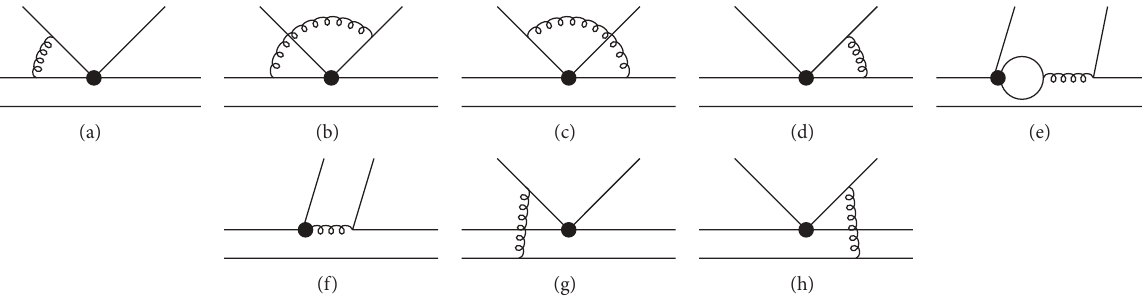
Figure 1: Order of 𝛼 𝑠 corrections to the hard scattering kernels. The upward quark lines represent the emission meson from the b quark decay vertex. These diagrams are commonly called vertex corrections, penguin corrections, and hard spectator scattering diagrams for (a)–(d), (e) and (f), and (g) and (h), respectively.